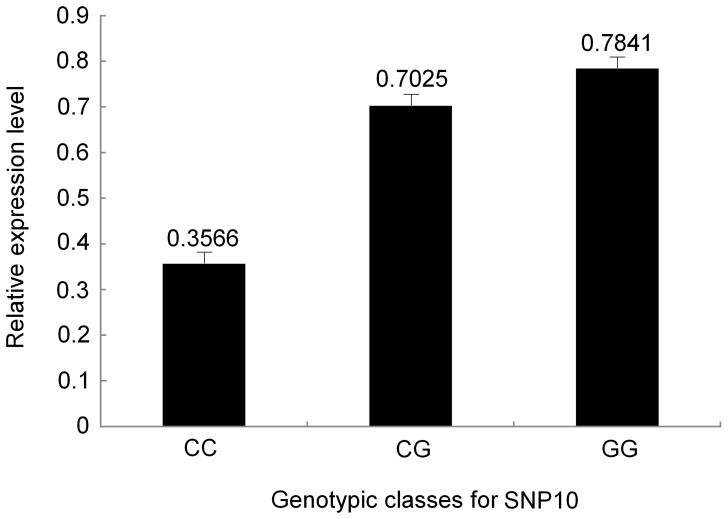
Expression levels of three genotypic classes for SNP10.The error bars represent+SD.